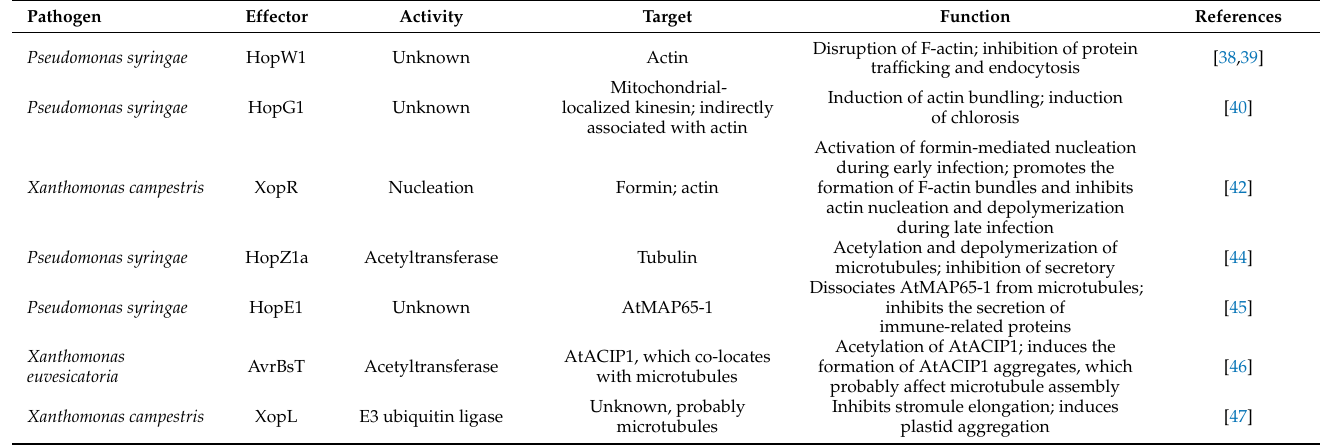
Table 1. Bacterial effectors targeting the